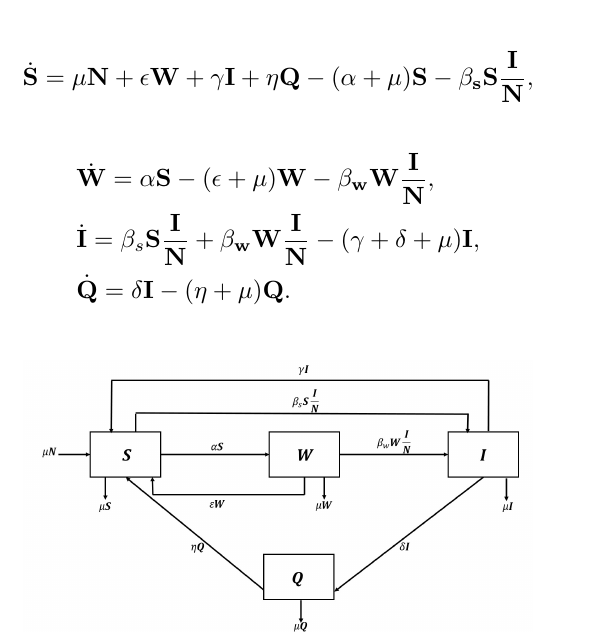
Figure 1. The transfer diagram of model